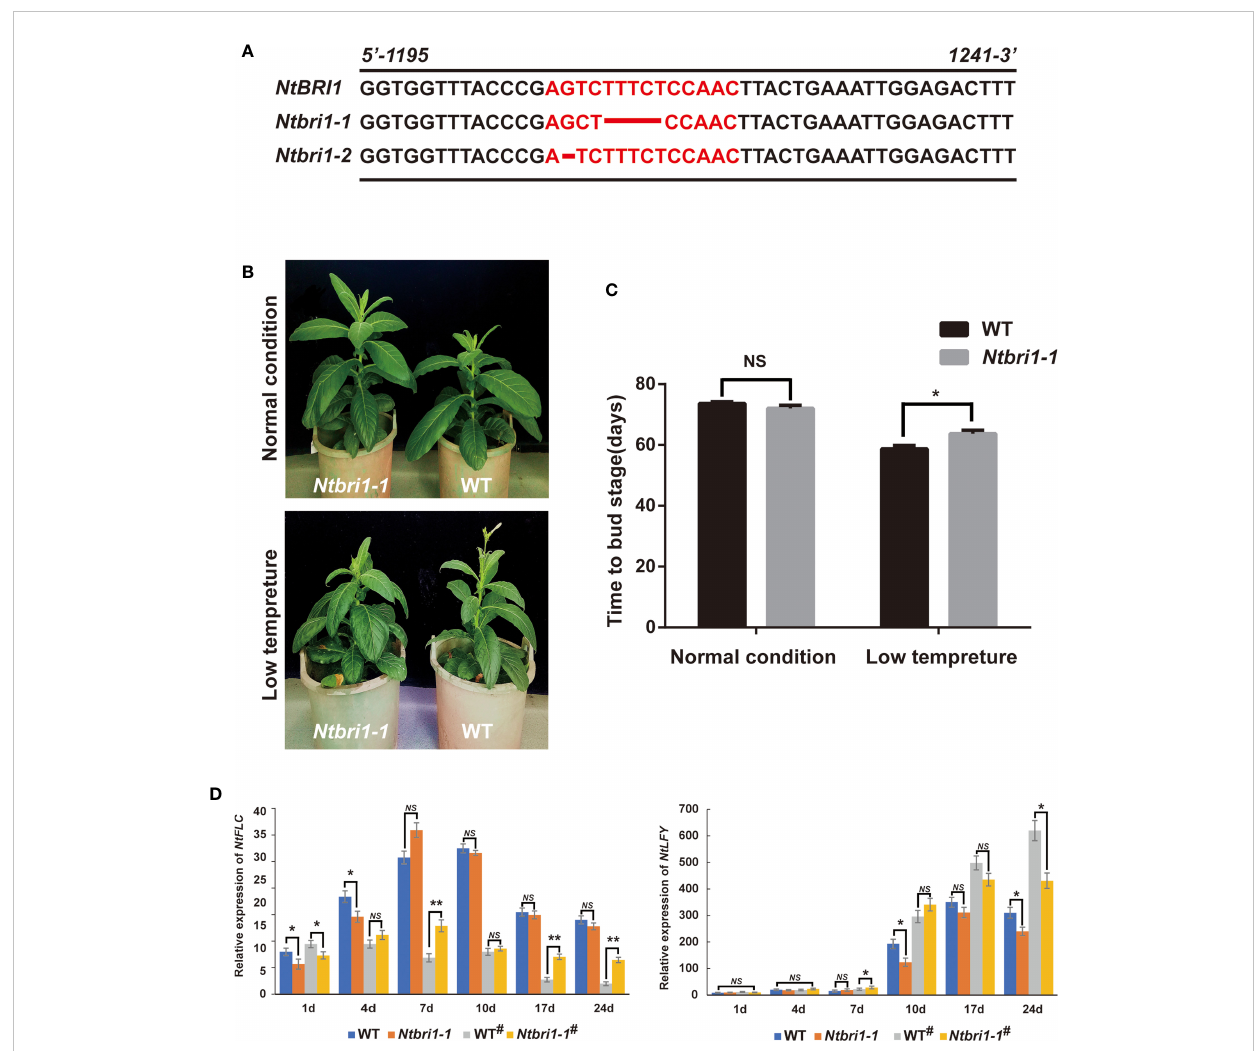
FIGURE 6 Cold induced early fl owering is suppressed in NtBRI1 mutant . (A) The Crisper/Cas9 meditated gene edited site of NtBRI1 in Ntbri1-1 and Ntbri1-2 . (B) and (C) The phenotype of Ntbri1-1 plants in cold induced early fl owering in tobacco. 5 samples of each treatment were collected for observation, and the experiment was repeated three times. (D) the expression of NtFLC and NtLFY in Ntbri1-1 plants under normal or cold-induced conditions (# means cold treatment). The seedlings of WT and Ntbri1-1 plants were treated with cold stress (12°C for 10 days, 16h light/8h dark), and then all plants were moved into the greenhouse (28°C, 16h light/8h dark). The samples were collected in 1d, 4d, 7d, 10d, 17d and 24d after cold treatment for qRT-PCR. Signi fi cant changes measured by Student ’ s t test (** means p <